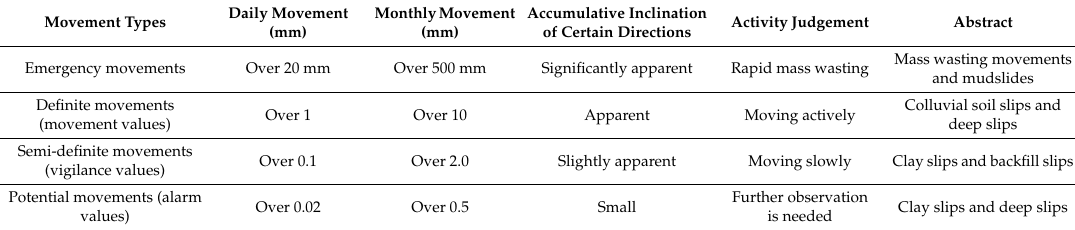
Table 2. Table of displacement speed and side slope stability judgment and suggestions [45].